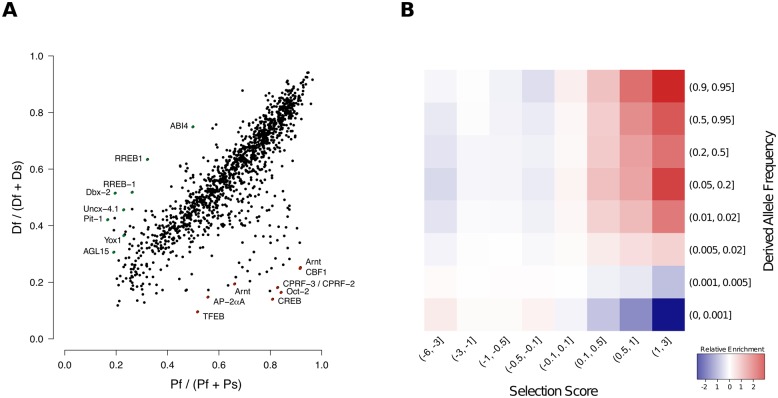
Examining selection on TF binding sites.(A) Comparison of fixed functional (Df) to fixed silent (Ds) (y-axis) versus polymorphic functional (Pf) to polymorphic silent (Ps) (x-axis) variants across all of the binding sites for each TF examined. Scores towards the top left are suggestive of positive selection (excess of fixed functional changes) while scores towards the bottom right are suggestive of weak negative (purifying) selection. Several of the highest- and lowest-scoring factors are shown labeled with the corresponding TF. (B) Derived allele frequency for SNPs within TF binding sites. For each pairwise bin of of DAF (rows) and selection score (columns), the enrichment is defined as the ratio between the observed proportion of SNPs in that bin and the expected (i.e., the product of the two marginal probabilities).